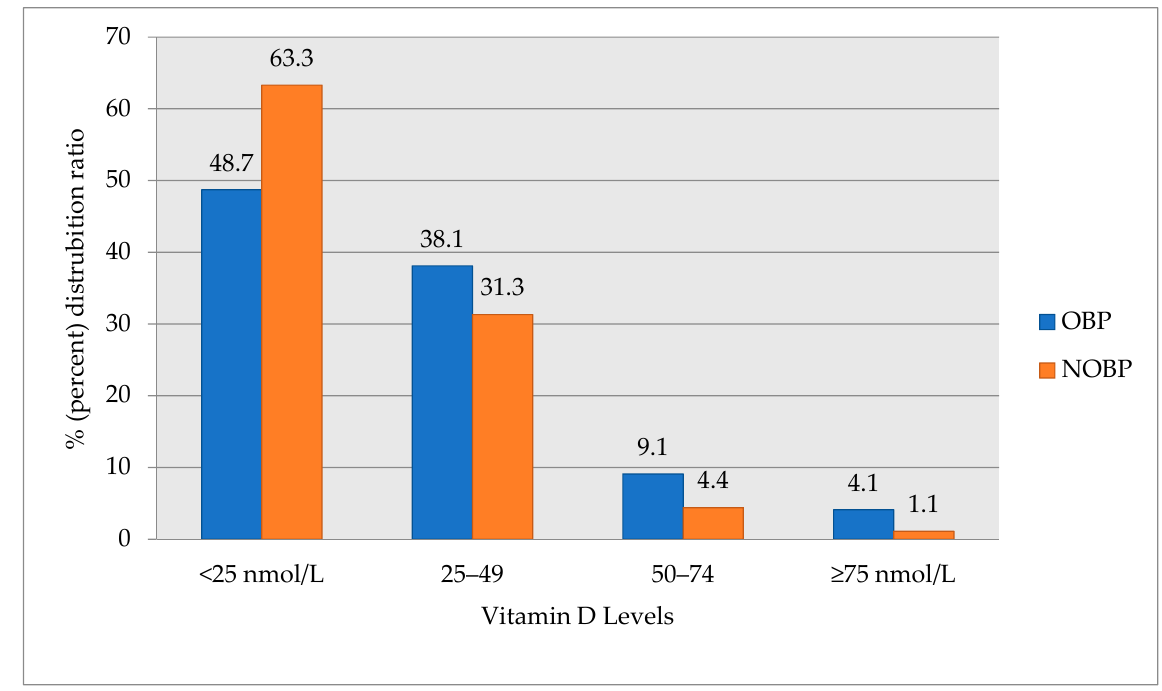
Figure 2. Distribution of vitamin D levels by groups. OBP, optimal blood pressure; NOBP, non-optimal blood pressure.